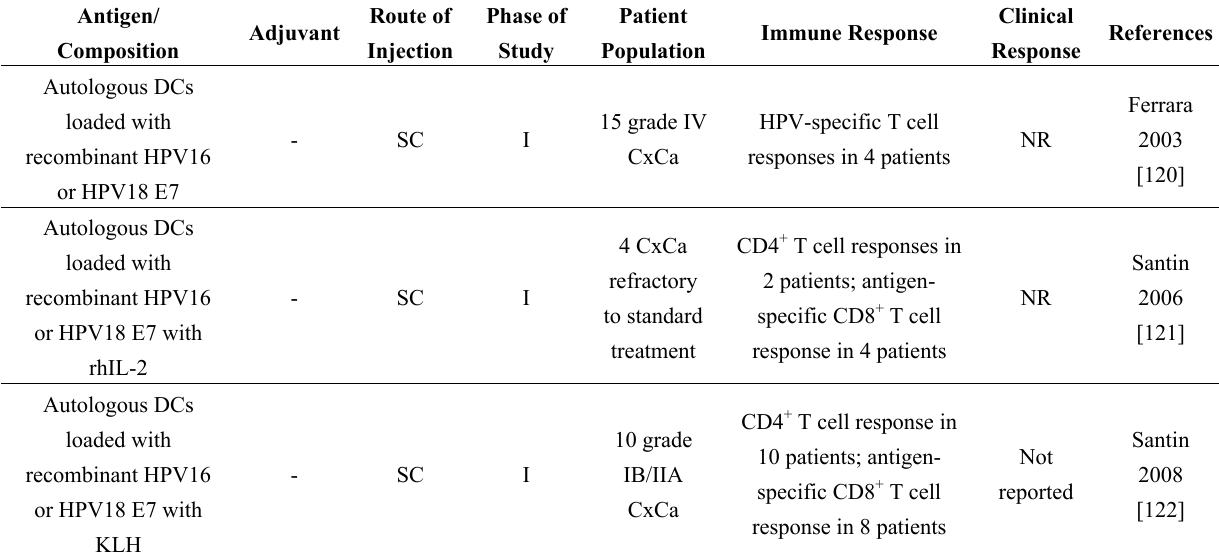
Table 4. Clinical studies with dendritic cell (DC)-based